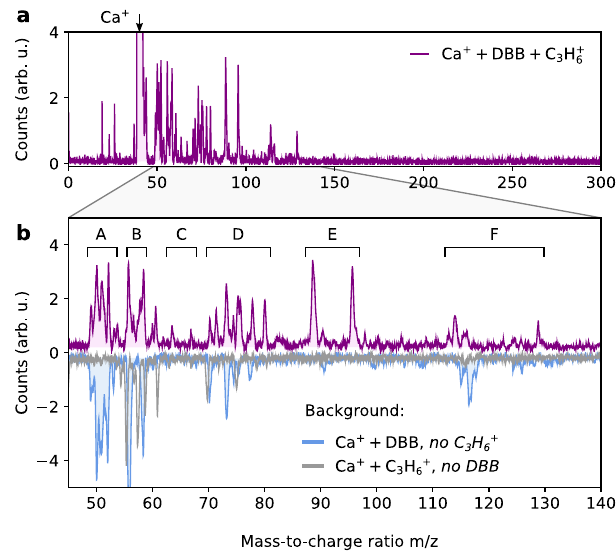
Fig. 3 Mass spectra of reaction products. a Overview time-of- fl ight mass spectrum acquired after 2min of reaction of DBB with propene ions. The spectrum shows a strong signal of Ca + at 40u and several product peaks. No signal could be detected at the expected mass of the cycloadduct at 252 and 256u due to fragmentation. b Magni fi ed view of the mass range showing the product signals (top trace) and comparison with control measurements in which either propene ions or DBB were absent from the experiment (lower inverted traces). The spectrum consists of several bands A – F corresponding to different fragments of the cycloadduct, see text for